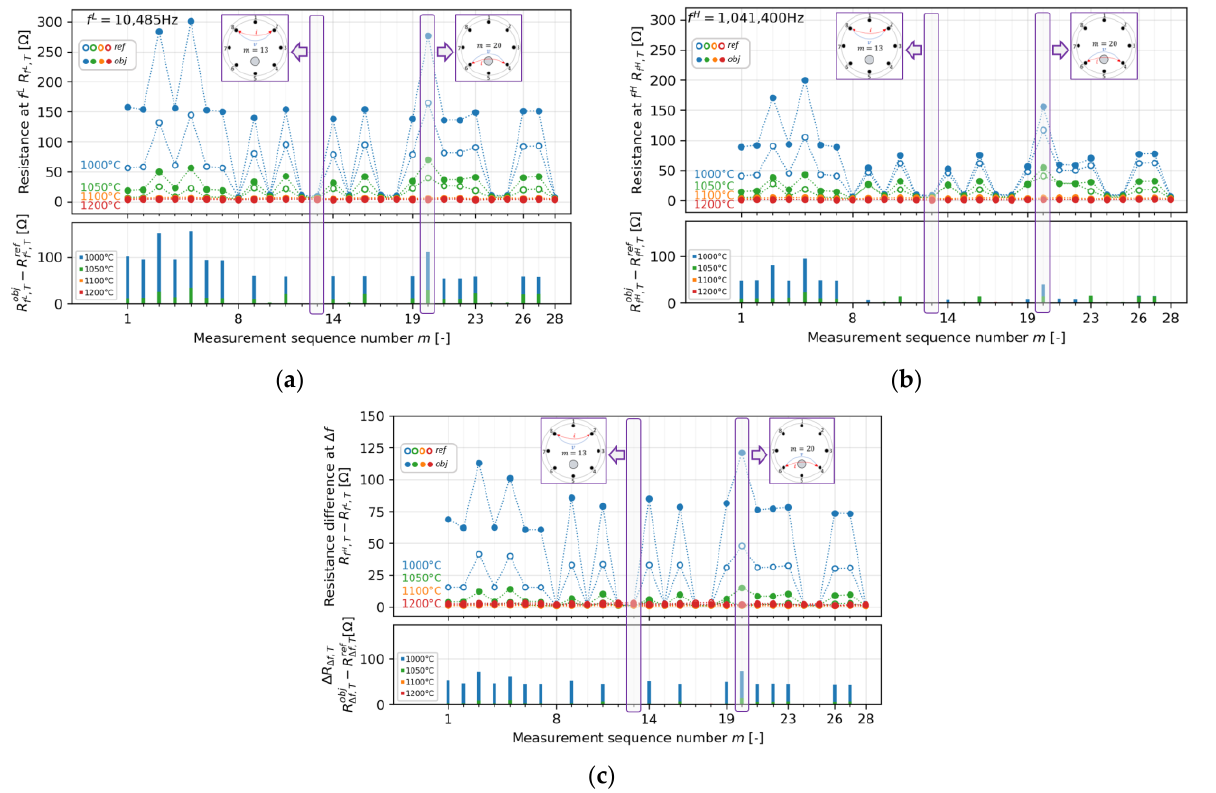
Figure 9. Resistance plots of all measurement pairs in the case of T = 1000, 1050, 1100, and 1200 ° C at the determined ( a ) f L = 10,485 Hz, ( b ) f H = 1,041,400 Hz, and ( c ) the determined resistance difference, ∆ R ∆ f , T , between the object and the reference.